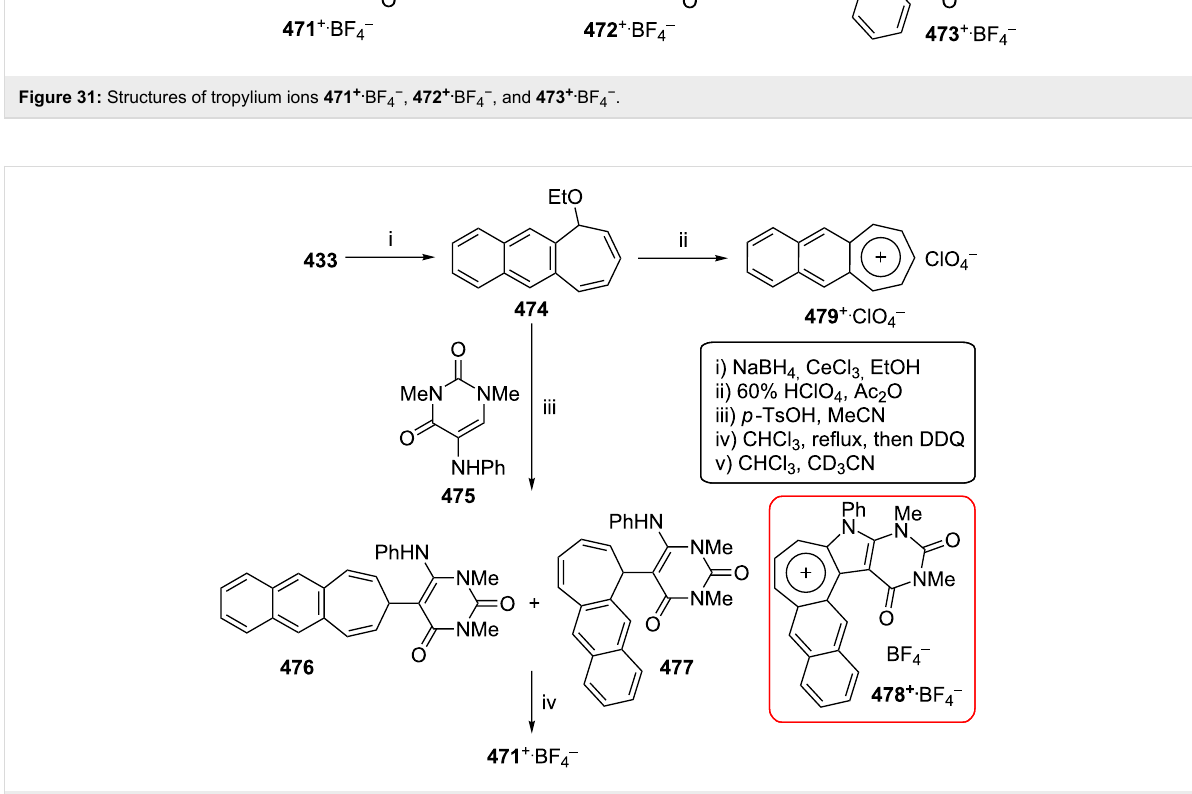
Scheme 87: Synthesis of tropylium ions 471 +. BF 4 − and 479 +. ClO 4 − .